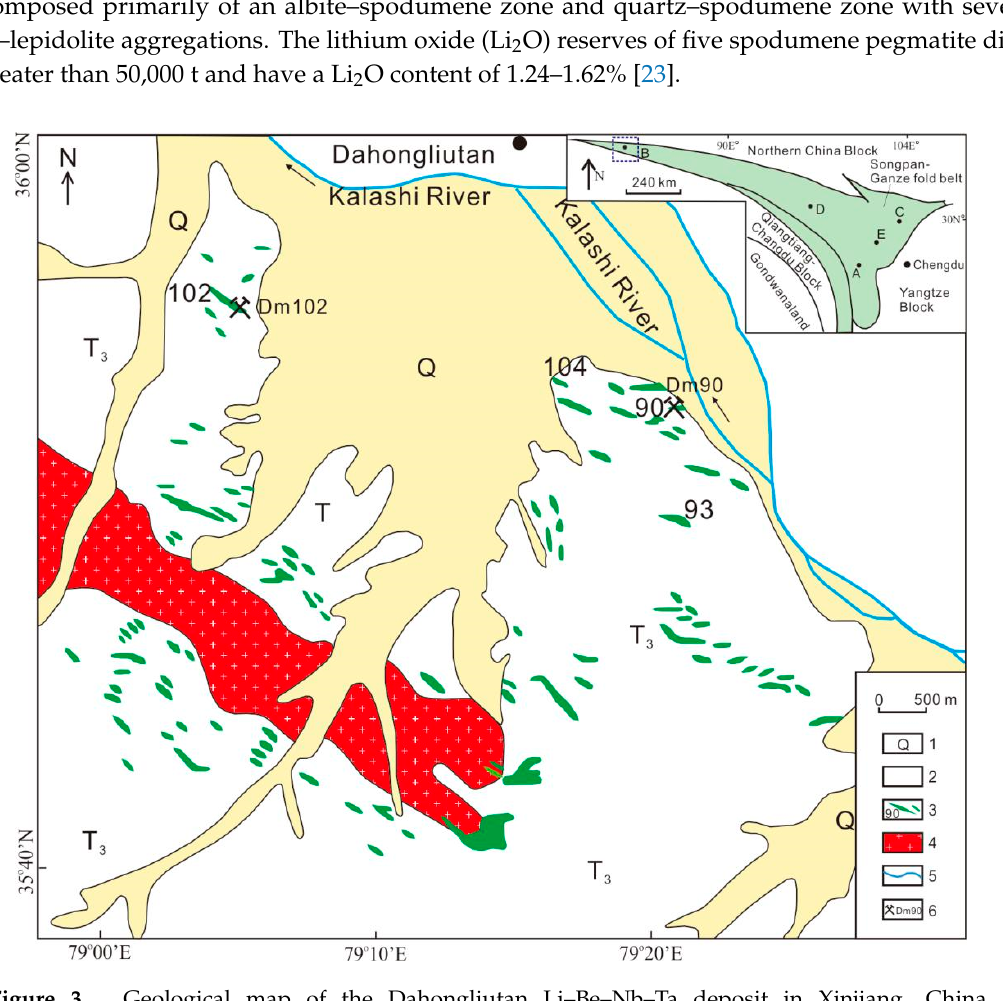
Figure 3. Geological map of the Dahongliutan Li–Be–Nb–Ta deposit in Xinjiang, China. 1: